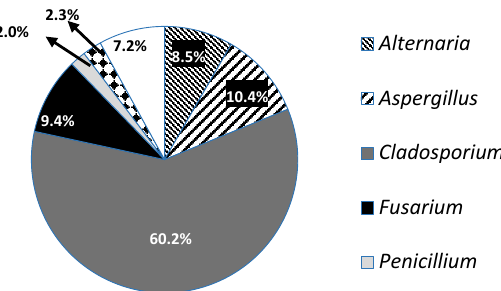
Figure 1. The composition of fungal constituents (%) in the atmosphere of Doha City during 1 April 2015 to 31 March 2016, using the gravimetric method (a total of 176 exposure samplings). Cladosporium was the most common fungal taxa in the air of Doha, comprising around two thirds of the total colony counts representing five species. C. cladosporioides was the most dominant species, with 70.5% of the total of the genus Cladosporium , followed by C. macrocarpum with 9.2% and C. sphaerosprmum with 6.4%. Cladosporium had double peaks of occurrence (April and February) and the lowest occurrence in July (Table 1; Figure 2).